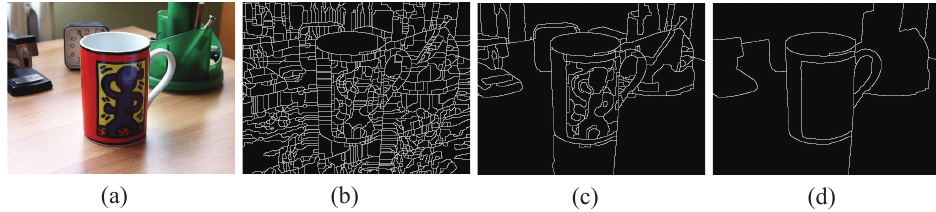
Figure 1. Contour of the cup image extracted by gPb with different thresholds. ( a ) Original image, ( b ) k = 0.01, ( c ) k = 0.3, ( d ) k = 0.6.